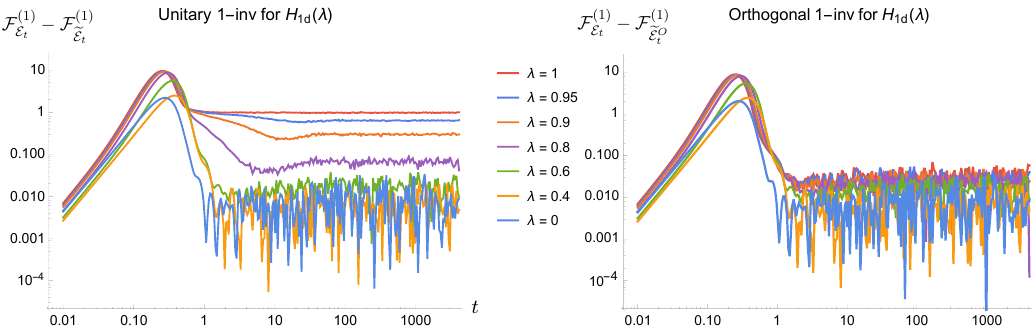
Figure 11 . Here we plot the approach to unitary and orthogonal 1-invariance for the local Hamil- tonian in eq. (5.6), tuning λ to break time reversal